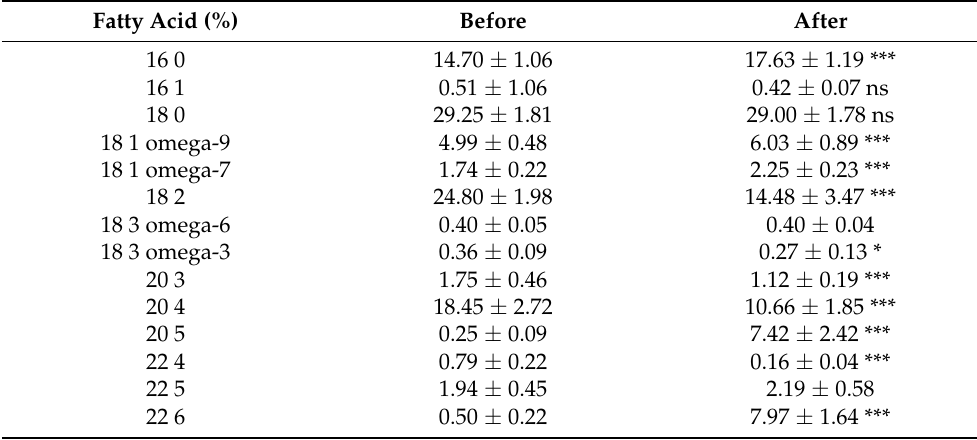
Table 3. Fatty acid profile in plasma phospholipids before and after treatment. Fatty Acid